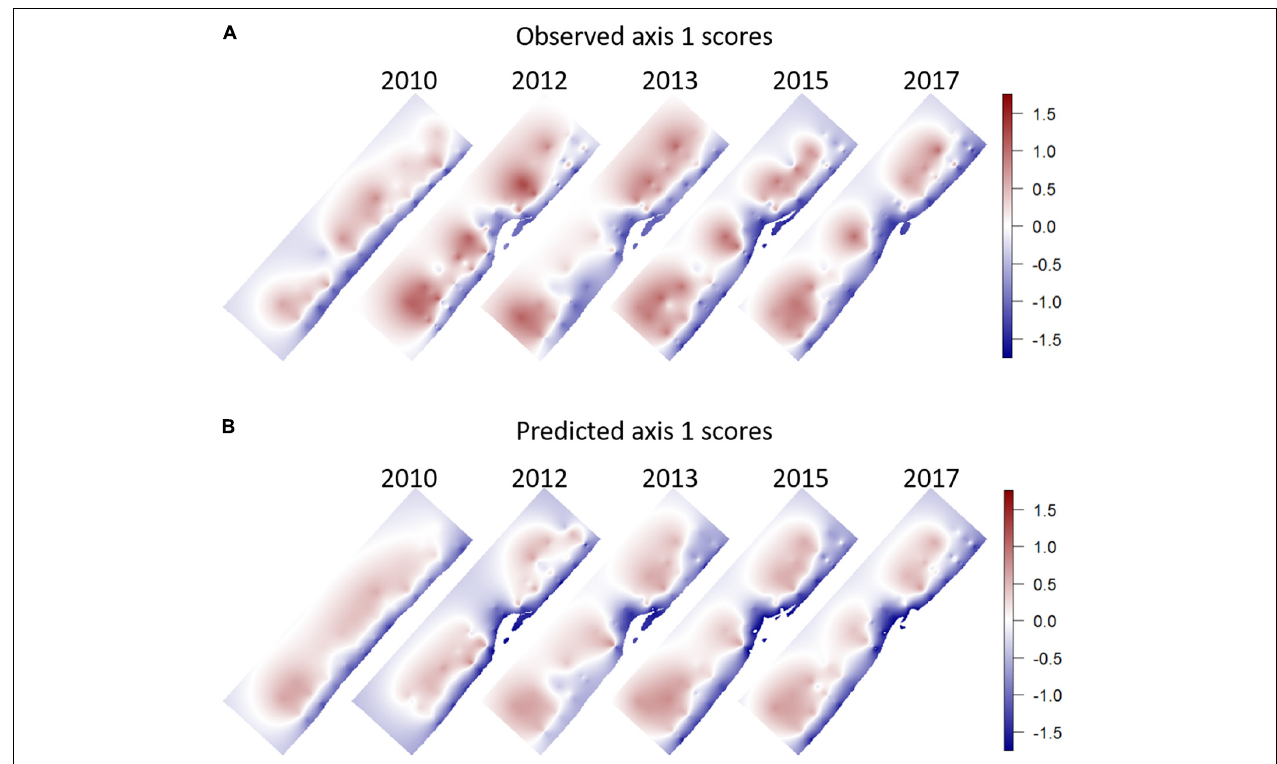
FIGURE 8 | (A) Observed, (B) Predicted scores on the first PCA axis. The prediction is based on a linear model fitted to the observations of 2010 and applied as a predictor to all years. Spatial interpolation was obtained by simple kriging of the values calculated/observed in the observation points, assuming anisotropy between onshore and alongshore